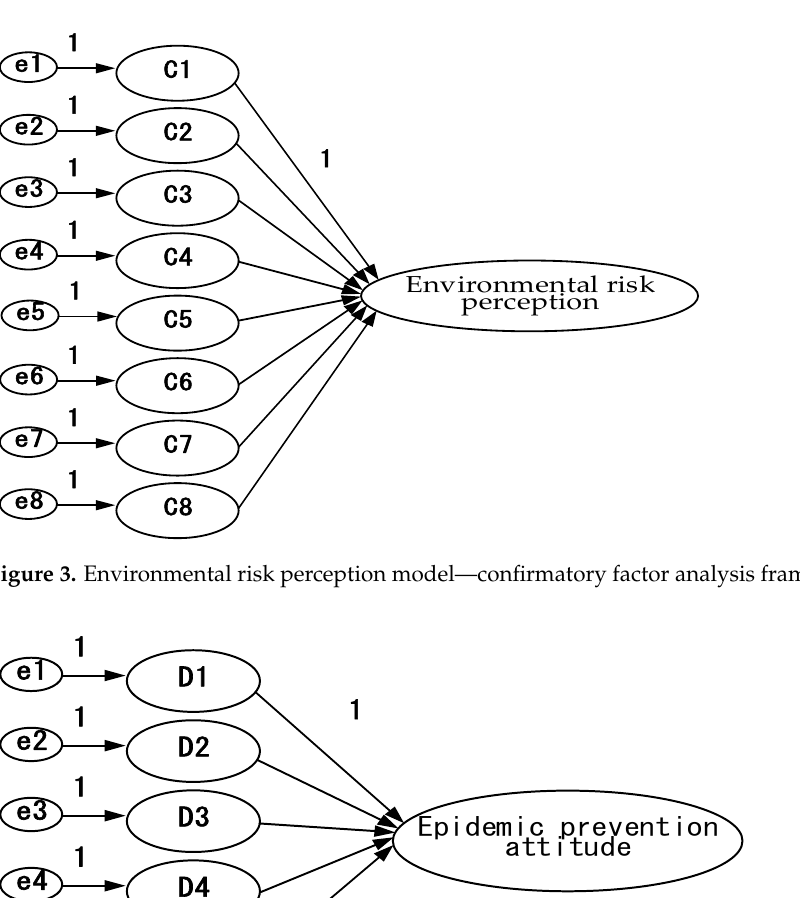
1 Figure 6. Travel intention model—confirmatory factor analysis framework.